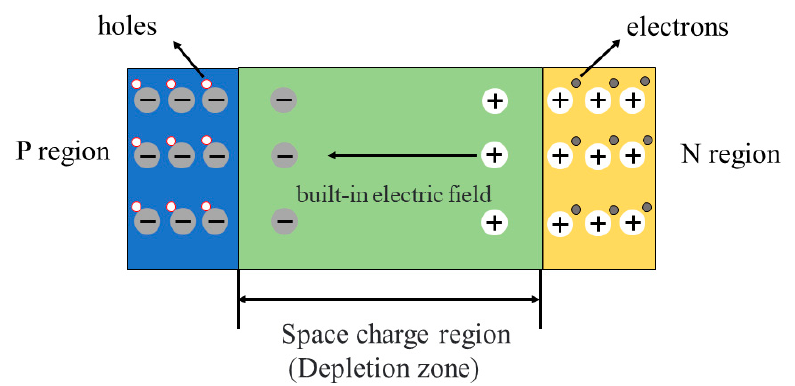
Figure 3. Schematic diagram of p-i-n junction.